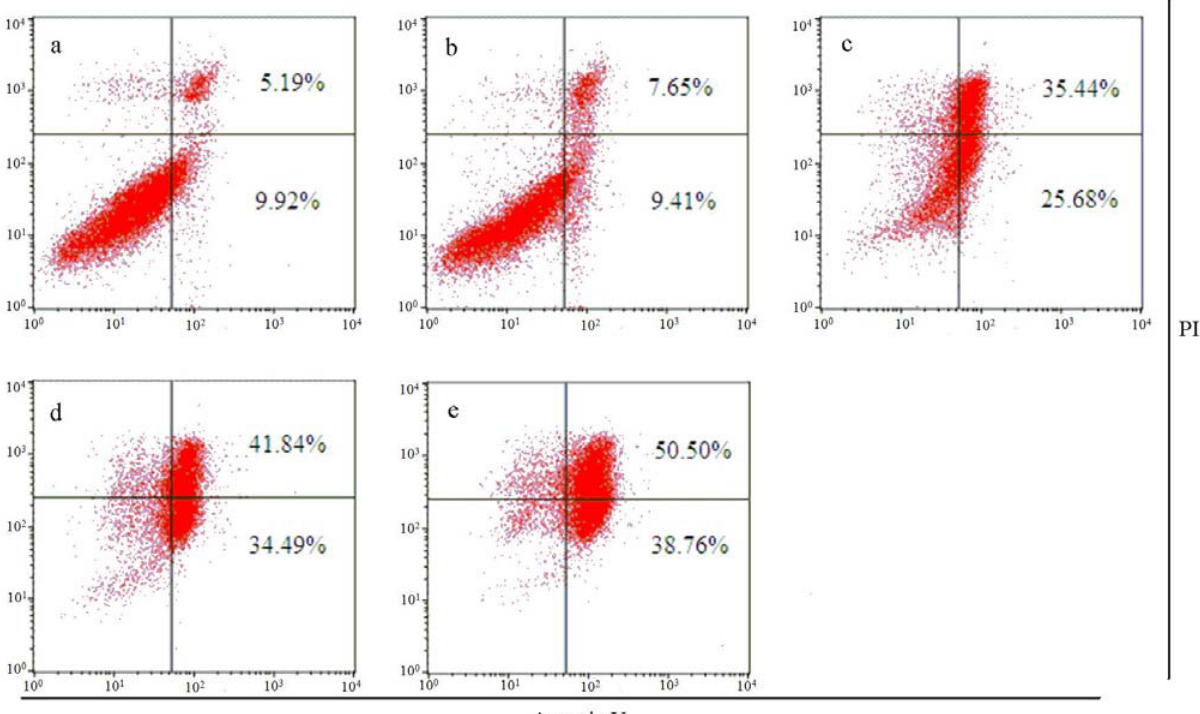
Figure 2. Effects of 4a on the induction of apoptosis in SW620 cells for 48 h: a, control; b, 5  M; c, 10  M; d, 20  M; e, 40  M. Cells were stained with annexin V-FITC and